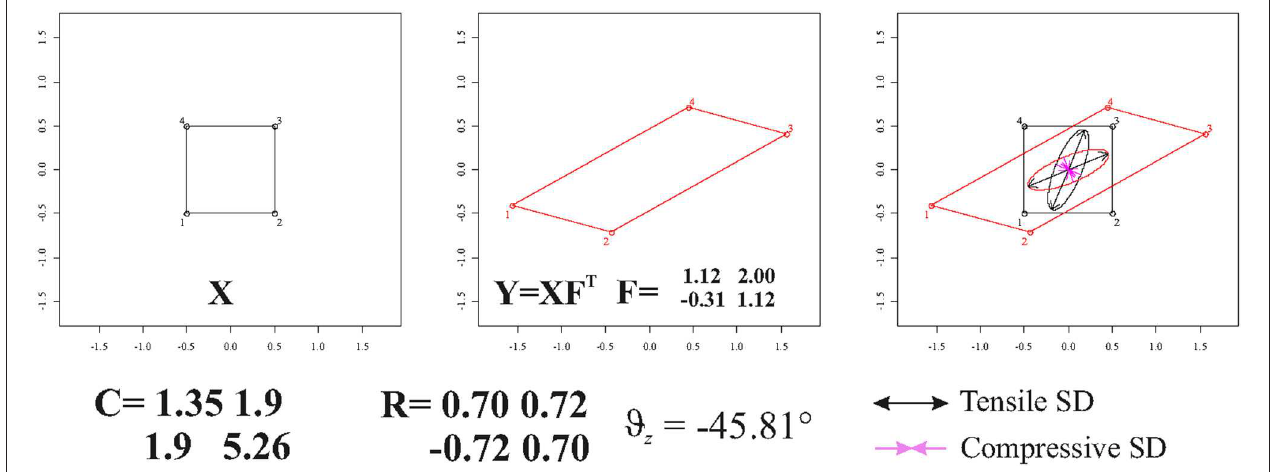
FIGURE 6 | The deformation of a square in a parallelogram and SD plotted on source and target configurations. C , F , and 2 z are also